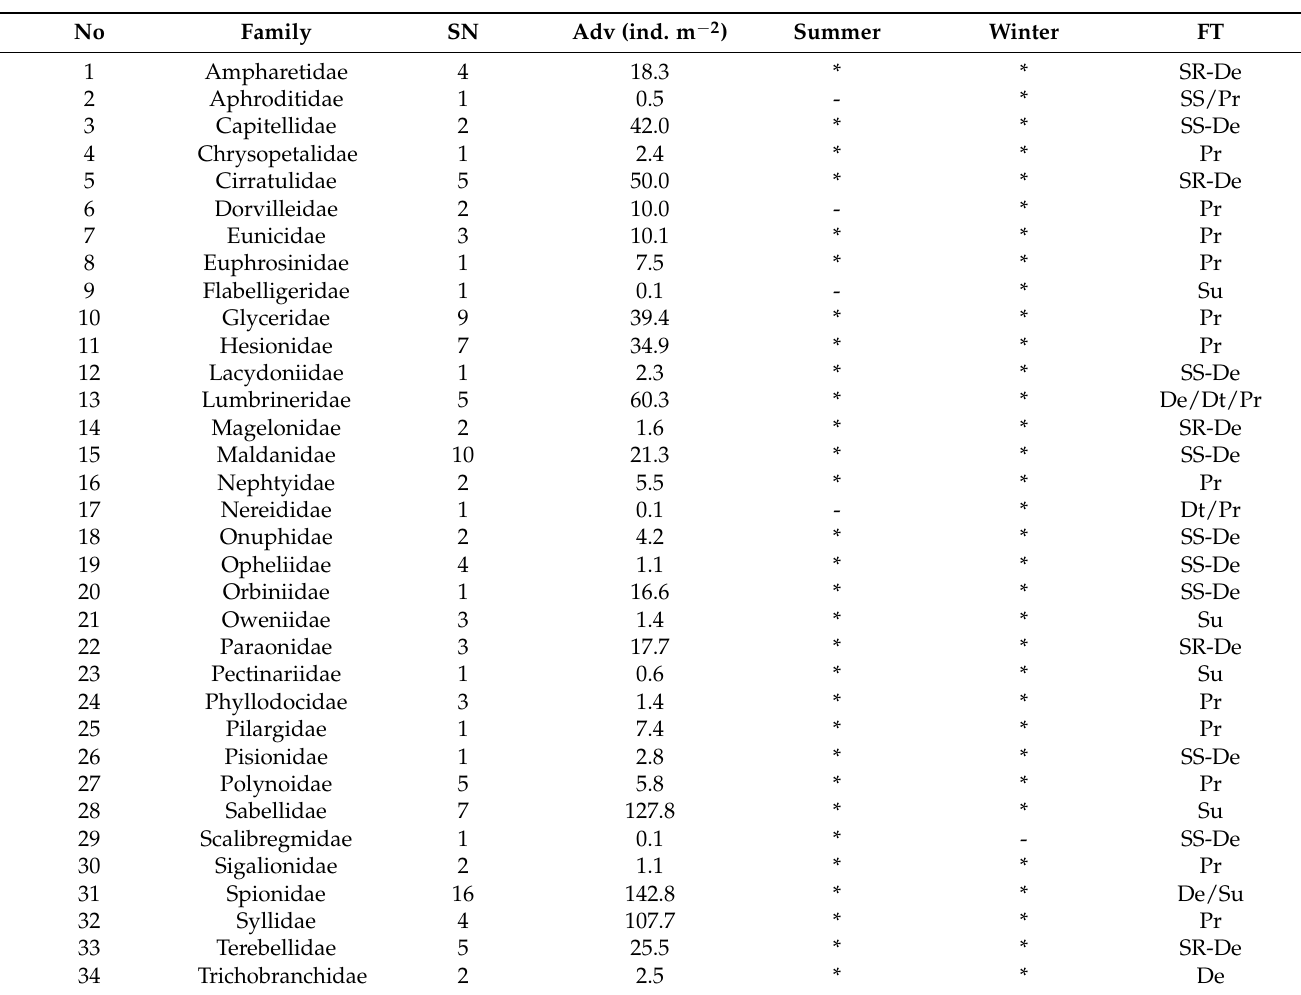
dae, and Nereididae appeared only in winter, and Scalibregmidae only in summer. The dominant polychaete species (>3%) were Pseudobranchiomma zebuensis , Scolelepis sp., Haplo- syllis spongiphila , Lumbrineris nipponica , Chaetozone spinosa , Syllis sp., Notomastus latericeus , Micropodarke dubia , Spiophanes bombyx , and Glycera unicornis (Table 3). The dominant species, P. zebuensis , showed the highest density in st06 in June (2195 ind. m − 2 ). At that time, the second most abundant species was Scolelepis sp. (995 ind. m − 2 ). Table 2. List of polychaete species and family information at Ulleungdo in spring and winter. SN, species number; Adv, Average density; FT, feeding type; SR-De, surface deposit feeder; SS-De, subsurface deposit feeder; Dt, detritus feeder; Su, suspension/filter feeder; Pr, predator; *, present; -,